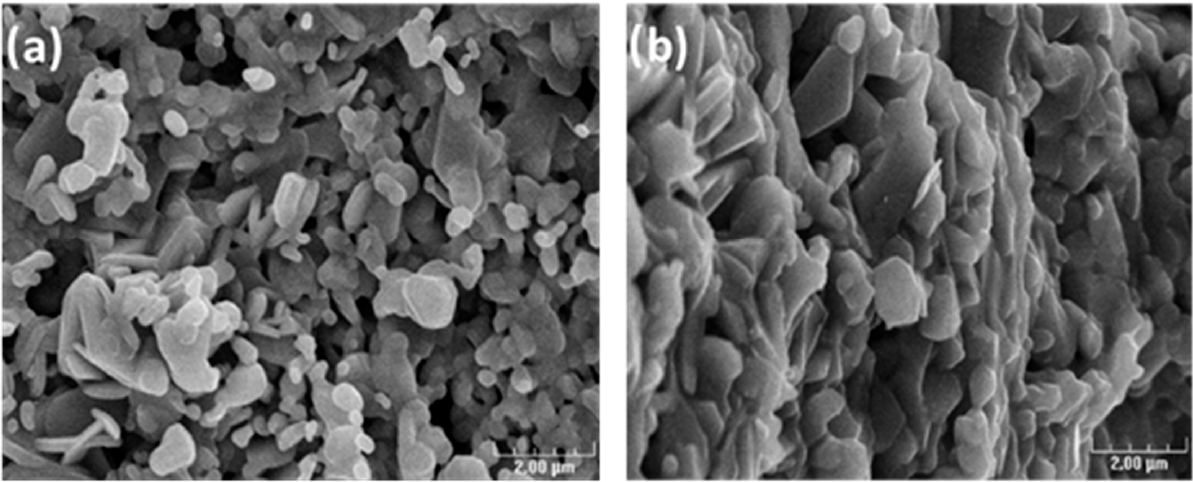
Figure 4. SEM images show the evolution of the texturization between BaM ‐ 0 ( a ) and BaM ‐ 100 ( b ) . 3.4. Crystallographic Study of BaM Samples Manufactured with Different Texturations X-ray diffraction data were processed with HighScore Plus software (Panalytical, UK) [27] for phase analysis and Jana2020 for Rietveld analysis. The latter made it pos- sible to examine the purity of the samples and to characterize the stacking of the crys- tallites. The crystallographic model used comes from the ICSD 259873 CIF file with cell parameters a = b = 5.8909 Å, c = 23.1882 Å and space group symmetry P 6 3 / mmc . The Rietveld analysis shows that all samples are single-phase (Figure 5). After refinement, the cell parameters and R factors for BaM-0 are a = b = 5.8928 Å, c = 23.2295 Å and Robs = 3.67, wRobs = 4.47, Rall = 4.78, wRall = 4.68, GOF = 1.19, whereas and BaM-100, they are a = b = 5.8921 Å, c = 23.2161 Å and Robs = 5.41, wRobs = 5.60, Rall = 6.42, wRall = 5.79, GOF = 1.26.